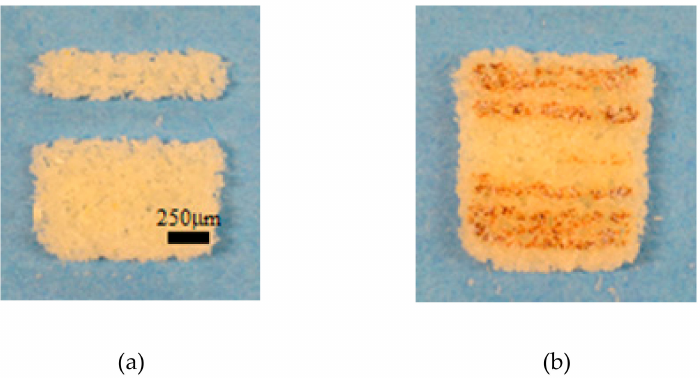
Figure 7. An example of two defective layers caused by laser fluctuation at scanning speed of 50 mm / s or 100 mm / s. (a) incomplete layer at lower bound. (b) Discolored bone traces at upper